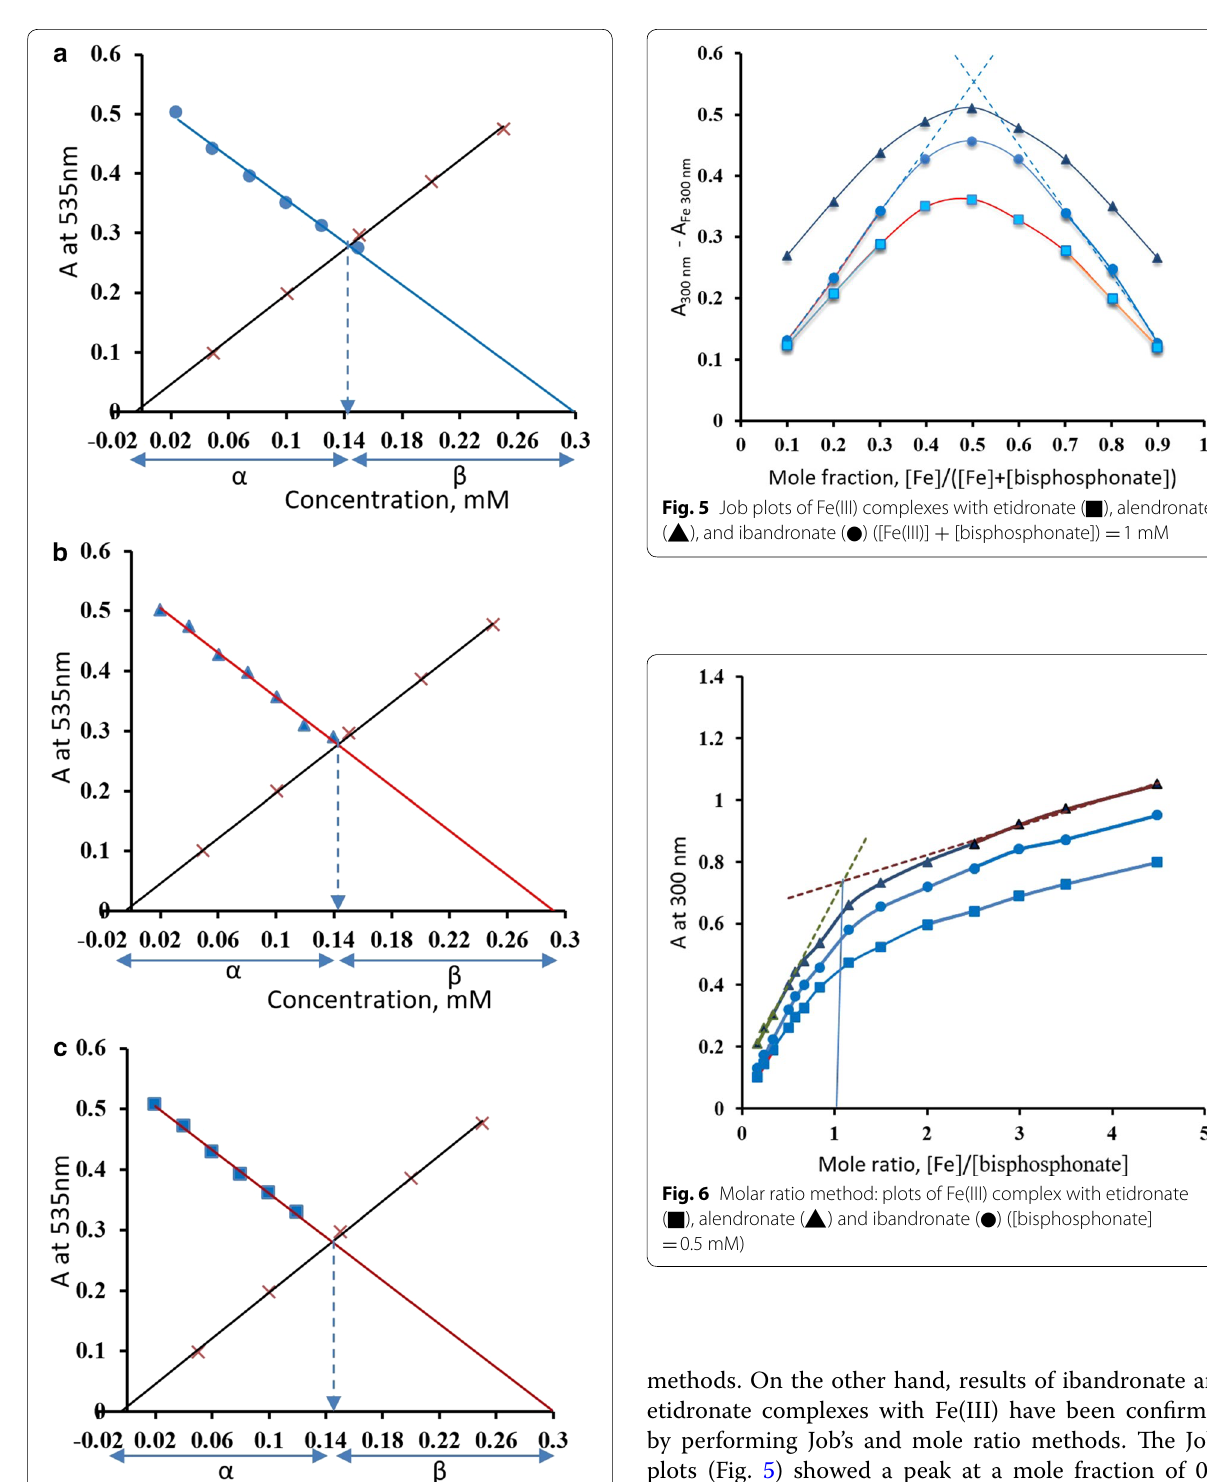
methods. On the other hand, results of ibandronate and etidronate complexes with Fe(III) have been confirmed by performing Job’s and mole ratio methods. The Job’s plots (Fig. 5) showed a peak at a mole fraction of 0.5, whereas the tangents of straight-line portions of the mole Fig. 4 An overlay of Fe(III)-salicylate calibration curve ( ) with inverse ratio curves intersect at a value of 1 (Fig. 6). Therefore, × calibration curves of a ibandronate ( ● ), b alendronate ( ▲ ), and c results of both methods provide a further confirmation of etidronate ( ■ ) the 1:1 ratio determined by the ligand exchange method.